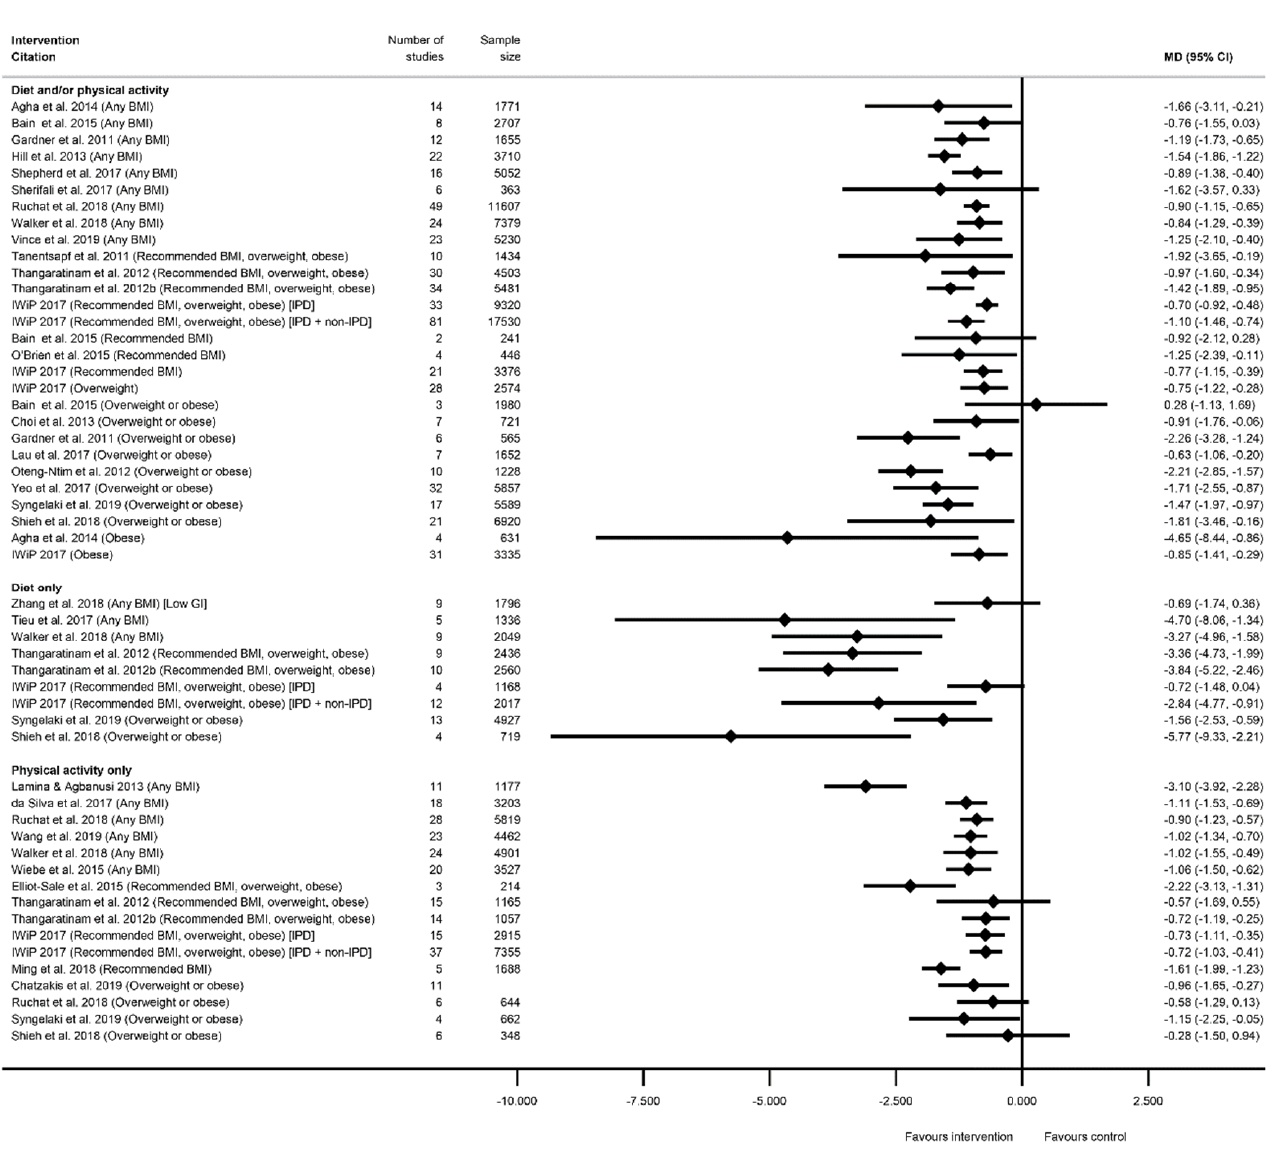
Figure 2. Forest plot of meta-analysis results for total gestational weight gain (GWG). * indicates the estimate is relative risk. Overall, 38 meta-analyses included women with any BMI (or combined recommended, overweight and obese BMI, excluding underweight), and 32 showed a significantly reduced mean GWG (ranging from − 0.21 kg (95% CI − 0.34, − 0.08) [79] to − 4.70 kg (95% CI −